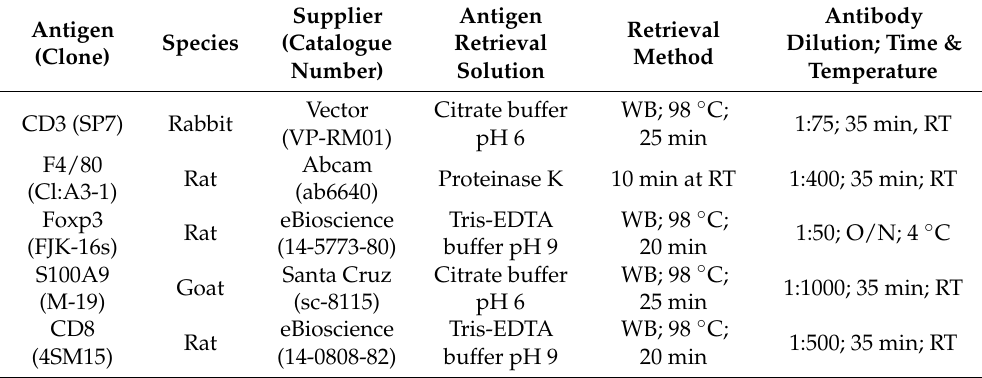
Table 1. Antigen retrieval methods, primary antibodies with dilutions, and incubation condi- tions for IHC. Citrate buffer (10 mM Sodium citrate, 0.05% ( v / v ) Tween 20). WB = water bath. RT = room